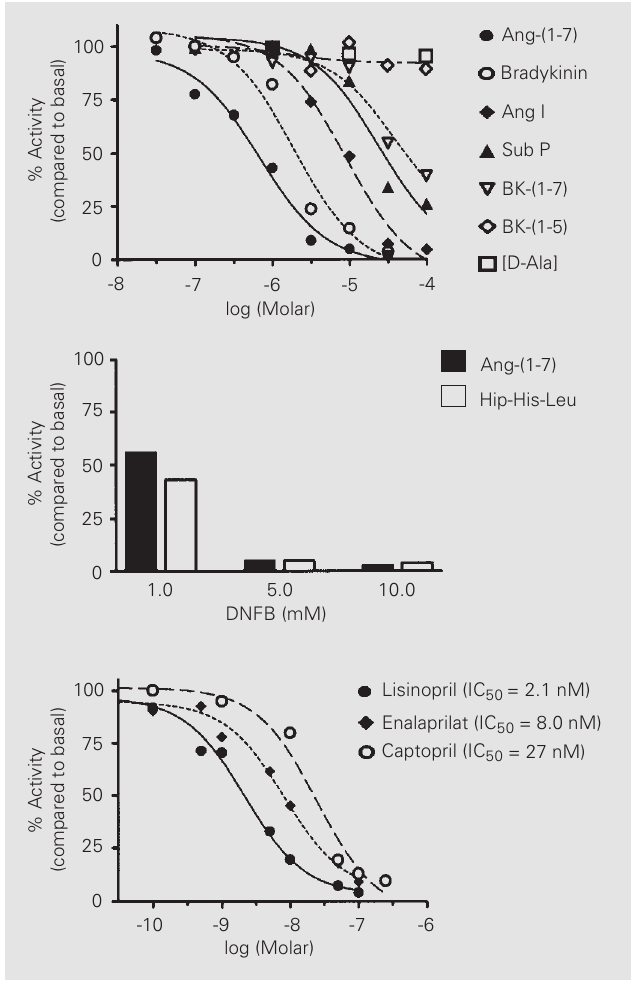
Figure 2 - Top panel , Comparison of the potencies of angiotensin and bradykinin peptides to compete for ACE activity determined with the synthetic substrate Hip-His-Leu as described (5). Sub P, Substance P; Ang, angiotensin; BK, bradykinin; [D-Ala], D-[Ala 7 ]-Ang-(1-7). Middle panel , Ef- fects of di-nitrofluorobenzene (DNFB) on the ACE-dependent hydrolysis of Ang-(1-7) and Hip-His-Leu. Lower panel , Potencies of the inhibitors lisinopril, enalaprilat and captopril to inhibit the hydrolysis of Ang-(1-7) by